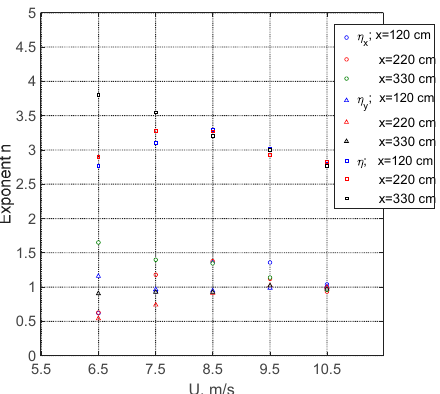
Figure 19. Comparison of exponents of the spectral tails for surface elevation and two components of the surface slope.